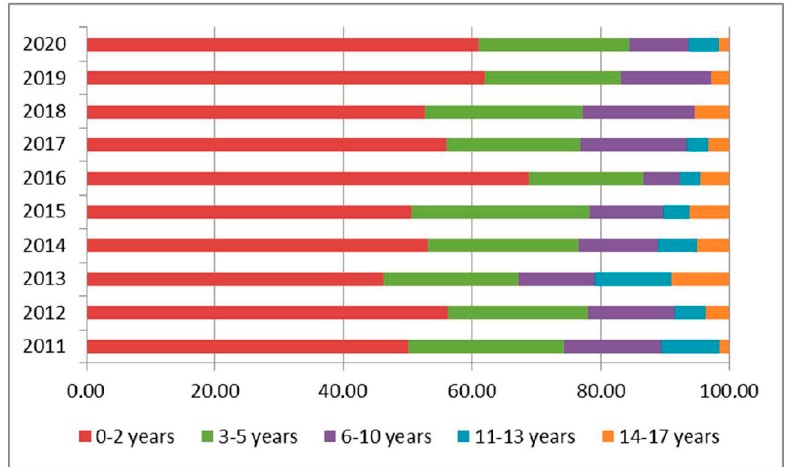
Figure 2. Proportion of hearing loss by age.